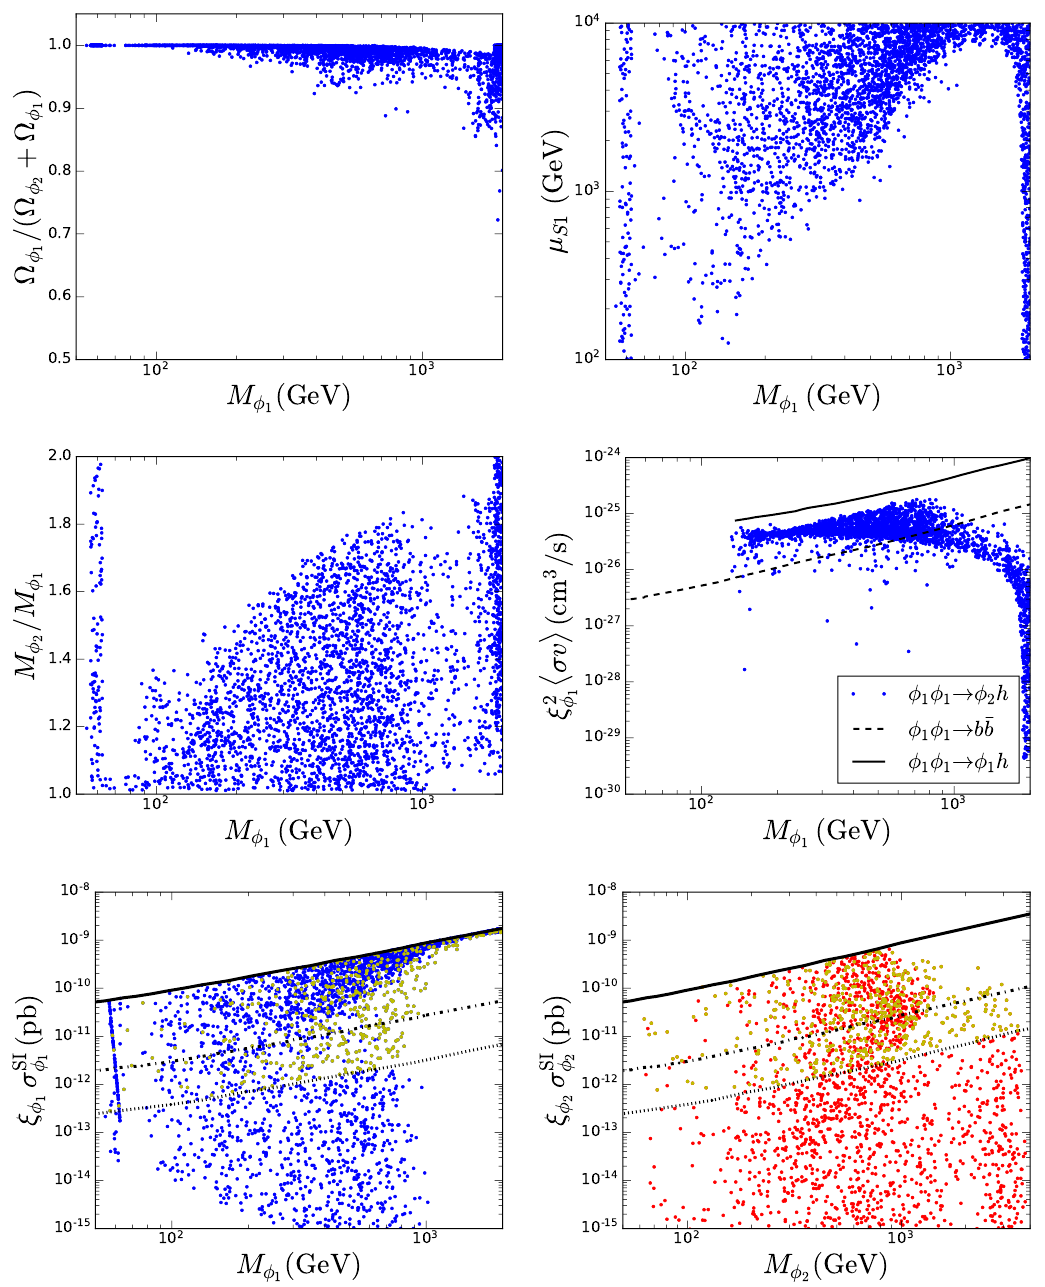
Figure 4 . A sample of viable points of the Z 4 model with M φ dimensions. The top panels show scatter plots of M φ In the center panels, the ratio of dark matter masses (left) and the most relevant indirect detection signal (right) are illustrated. The direct detection prospects are shown in the bottom panels for φ 1 (left) and φ 2